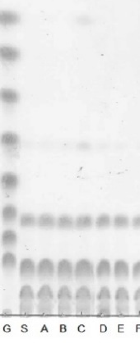
Figure 4. Enzymatic hydrolysis of SBC-oligosaccharides. G, standard; S, oligosaccharides produced by Leu. lactis SBC001; A, oligosaccharides treated with α -amylase; B, oligosaccharides treated with α -glucosidase; C, oligosaccharides treated with amyloglucosidase; D, oligosaccharides treated with pullulanase M1; E, oligosaccharides treated with β -glucosidase; F, oligosaccharides treated with β -1,3- D -glucanase.